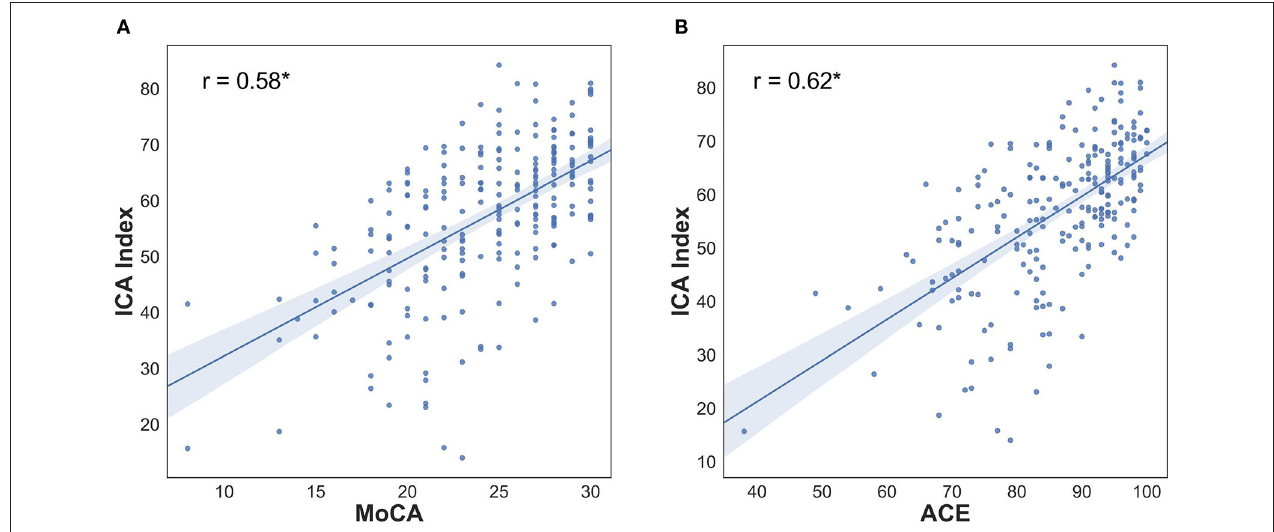
FIGURE 2 | ICA Index correlation with MoCA and ACE (A) Pearson correlation: 0.58, p < 0.0001, ICA Score Pearson correlation with MoCA is 0.58, p < 0.0001 (B) Pearson correlation 0.62, p < 0.0001; ICA Score Pearson correlation with ACE is 0.56, p < 0.0001. For breakdown of correlation with ACE subdomains see Table 3 .